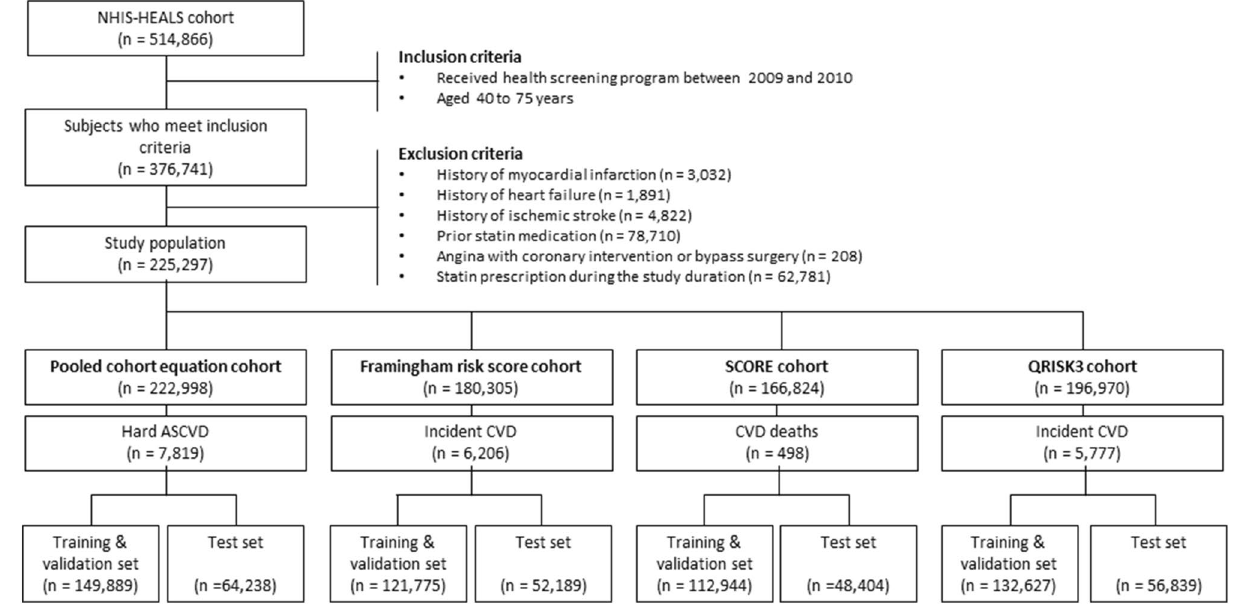
Figure 1. Description of the study population. NHIS-HEALS cohort national health insurance service- health screening cohort, SCORE systematic coronary risk evaluation, CVD cardiovascular disease, ASCVD atherosclerotic cardiovascular